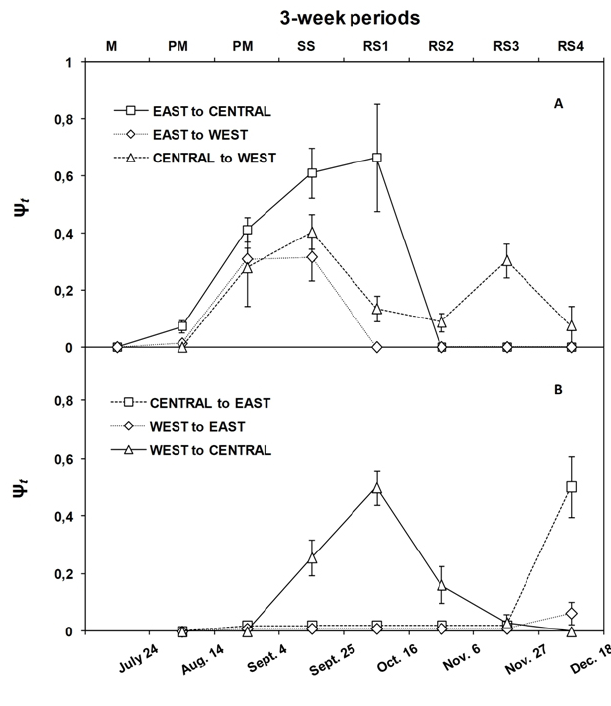
Fig. 3 . Estimates (± 1 SE) of movement probability ( y ) of radio-marked and neck-collared Canada Geese ( Branta canadensis maxima ) near Montréal, Québec during eight 3- week periods in 2004 along A) a decreasing and B) increasing hunting pressure gradient. Estimates are derived from the best model selected with AIC. See the Methods section for description of the